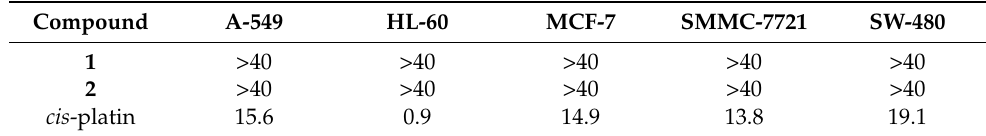
Table 2. Cytotoxic activity of compounds 1 and 2 a